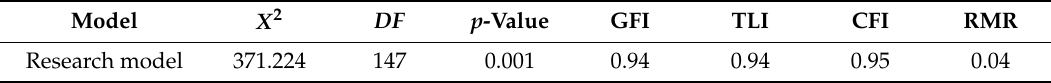
Table 6. Research model